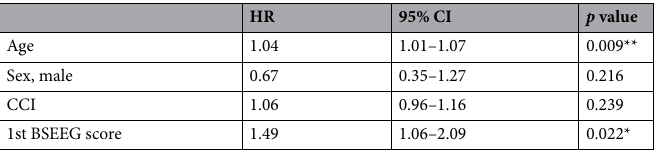
Table 3. Result of the Cox proportional hazard model in patients with sepsis (N = 118). CCI Charlson Commobidity Index. * p < 0.05; ** p <